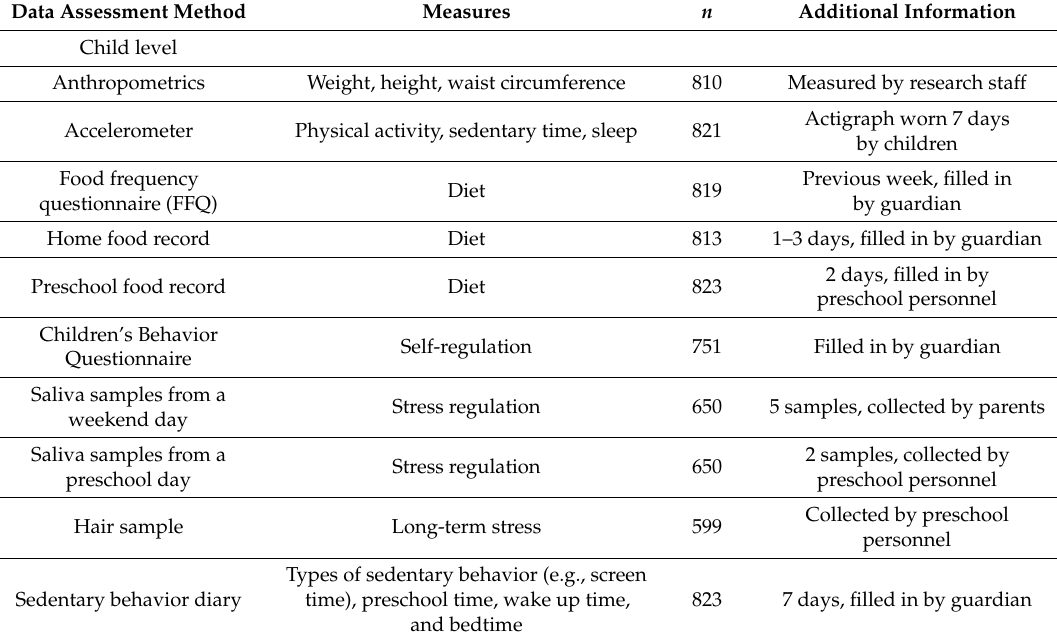
Data assessment methods and available data at different levels in the DAGIS survey